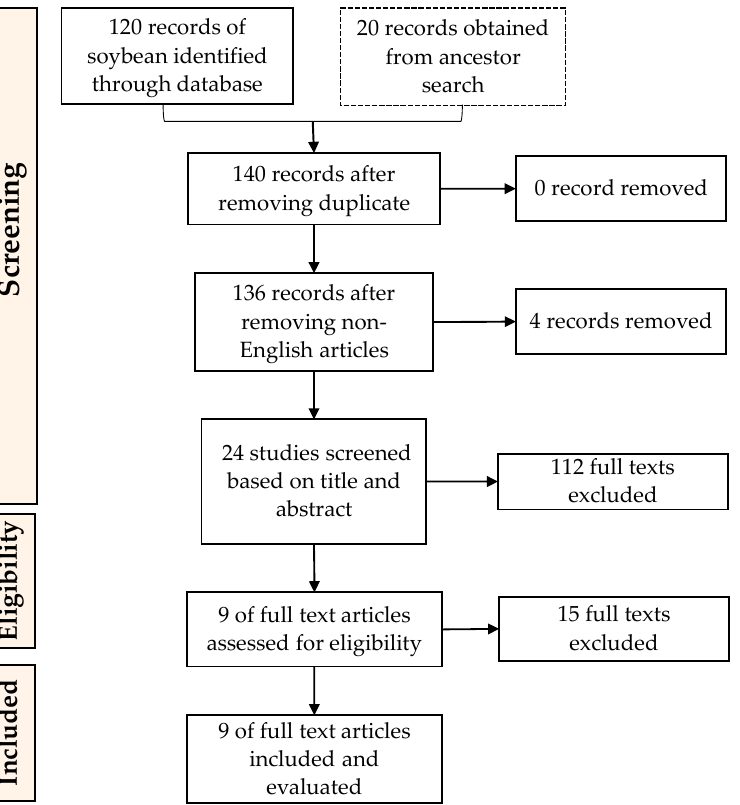
Figure 2. PRISMA guidelines for the inclusion of articles on the enzymatic preparation of ACEi peptides from soybean proteins.